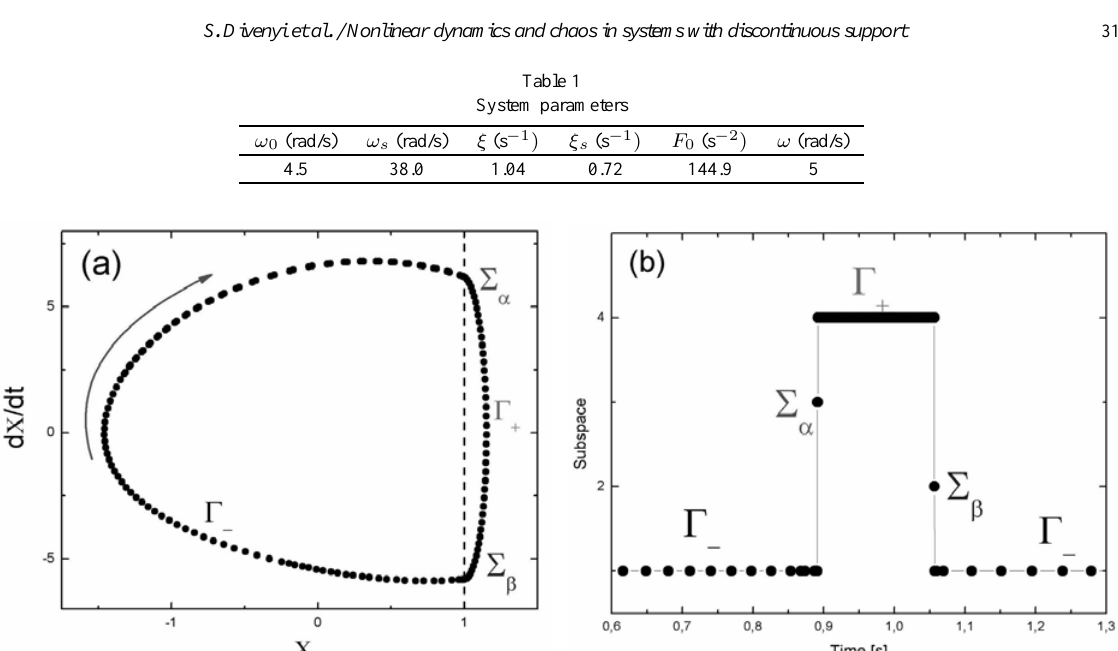
Fig. 3. Analysis of system evolution through the